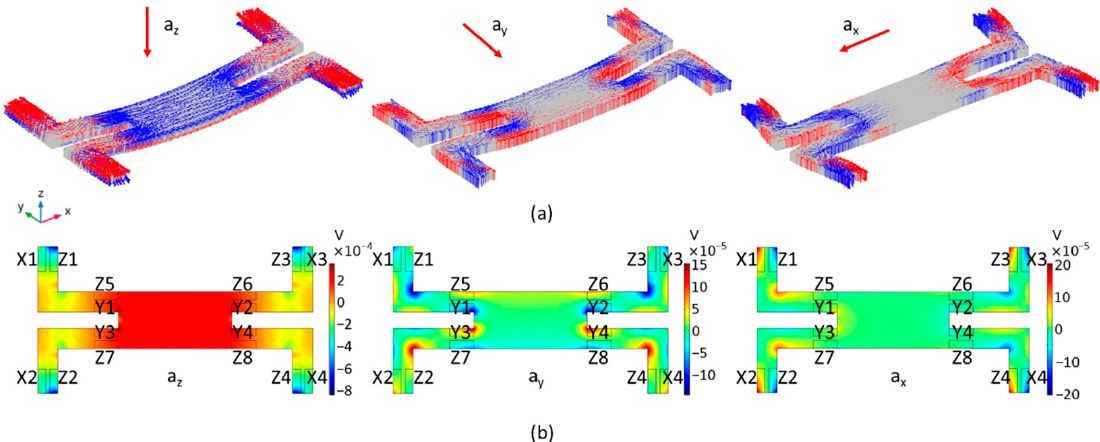
Figure 3. Numerical simulation results of the stationary analysis using COMSOL. ( a ) The structural deformation and stress distribution along the x , y , z -axis: the red arrow indicates tensile stress and the blue arrow indicates compressive stress; ( b ) The voltage distribution of tri-axial piezoelectric accelerometer along x , y , z -axis at the acceleration level of 1 g.